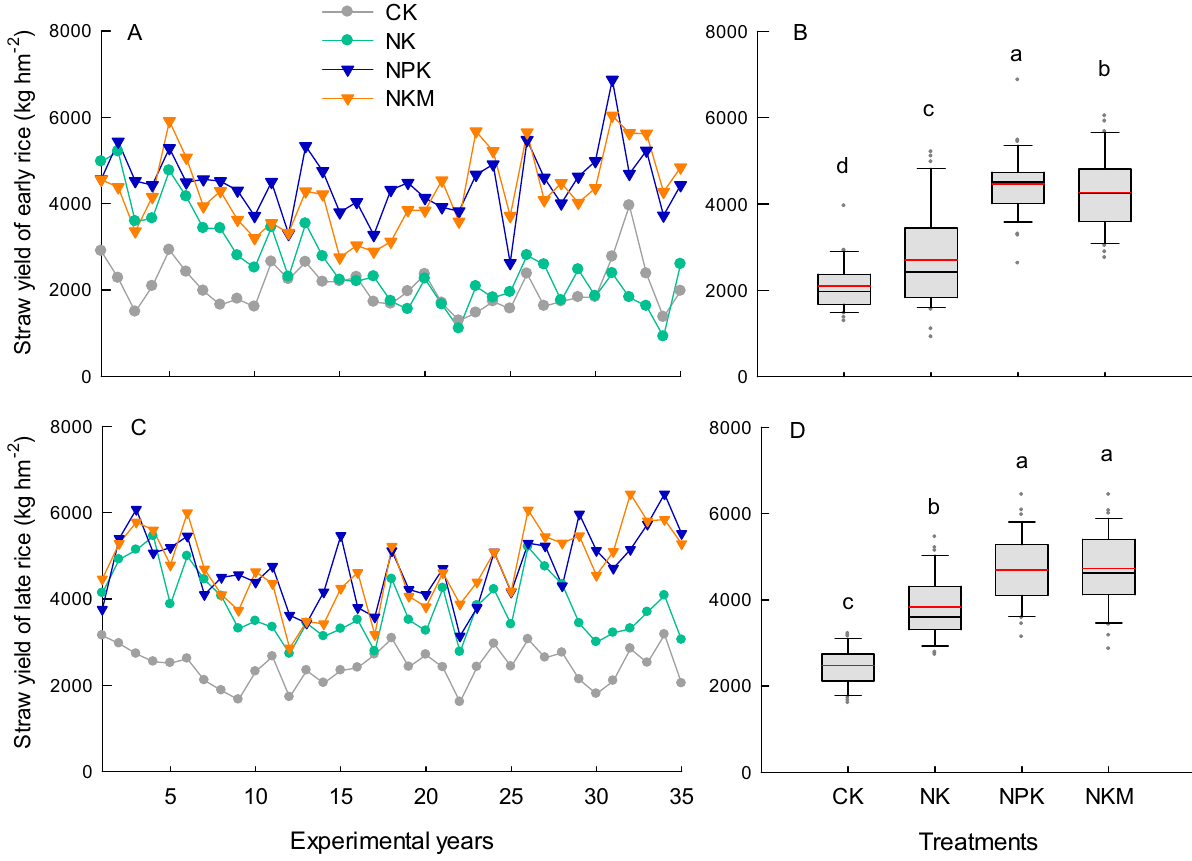
Figure 2. Variation and distribution of straw yields for early rice ( A , B ) and late rice ( C , D ) under different fertilization treatments CK, NK, NPK and NKM across 35 years. Red lines indicate the mean value, and different lower case letters indicate significant differences for the mean straw yield (n = 3) between treatments at p < 0.05 in ( B , D